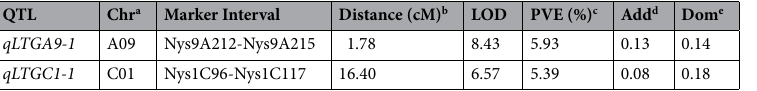
Table 3. Statistics of LTG QTL identified at four days after imbibition (DAI) in F 2:3 families. a Chr is the chromosome of rapeseed. b Distance means the distance between the left and right marker of the mapping QTL. c PVE represents the phenotypic variation of LTG in F 2:3 families by each QTL. d Add is the additive effect. e Dom is the dominant effect.